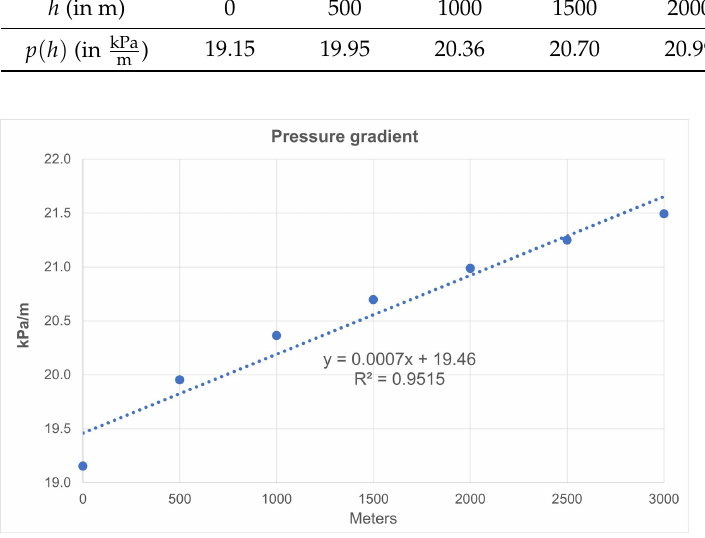
Figure 5. Pressure gradient estimates from